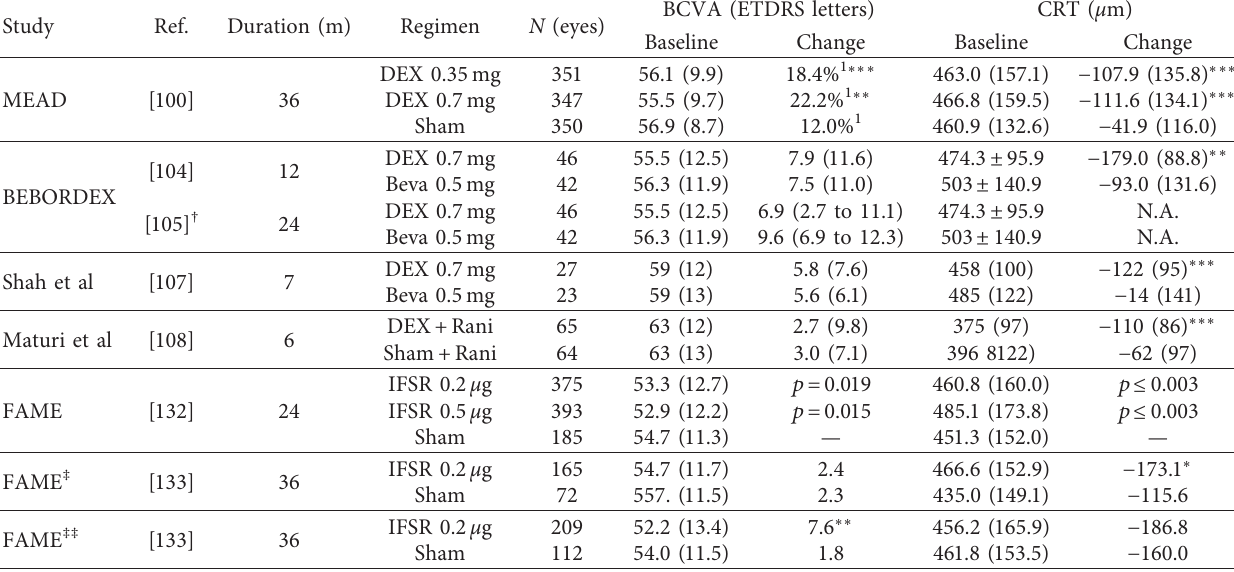
Table 5: Overview of the functional and anatomic results of dexamethasone intravitreal (DEX) and fluocinolone intravitreal implants. Study